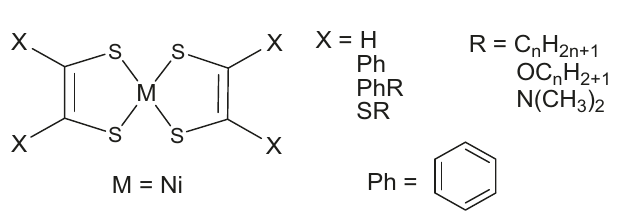
Fig. 2 | General structure of nickel bis(dithiolene) complex used for activating fusing agent. Unsaturated bidentate Dithiolene ligands, in which the two donor atoms are sulfur.